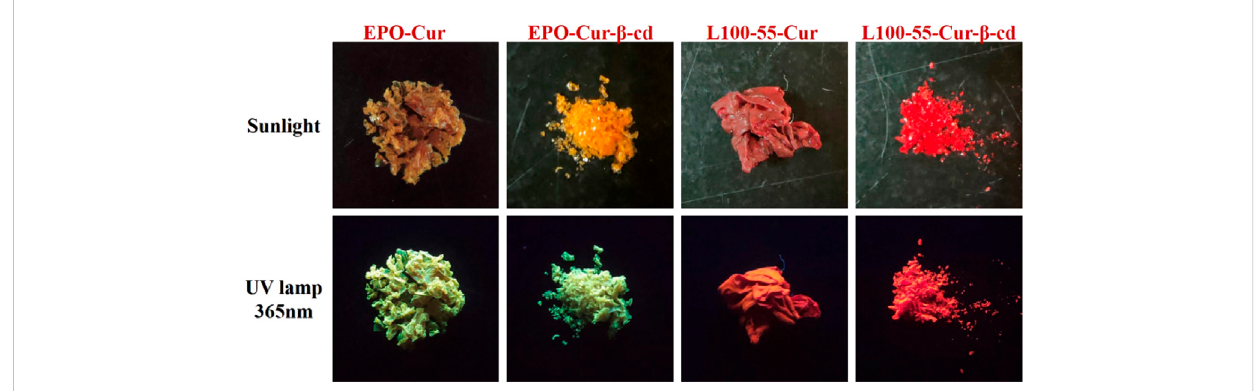
FIGURE 1 Sunlight and 365 nm images of four curcumin fl uorescence complexes.